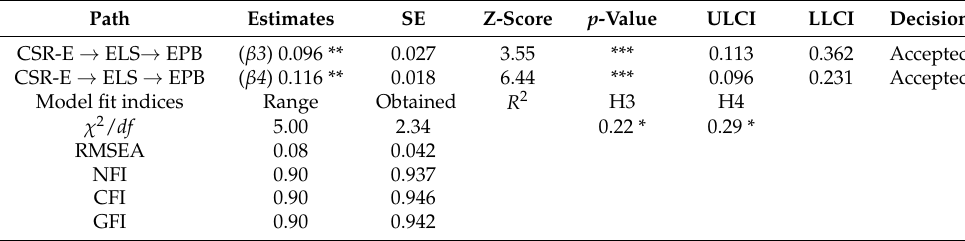
Table 5. Mediation and moderation results for H3 and H4.